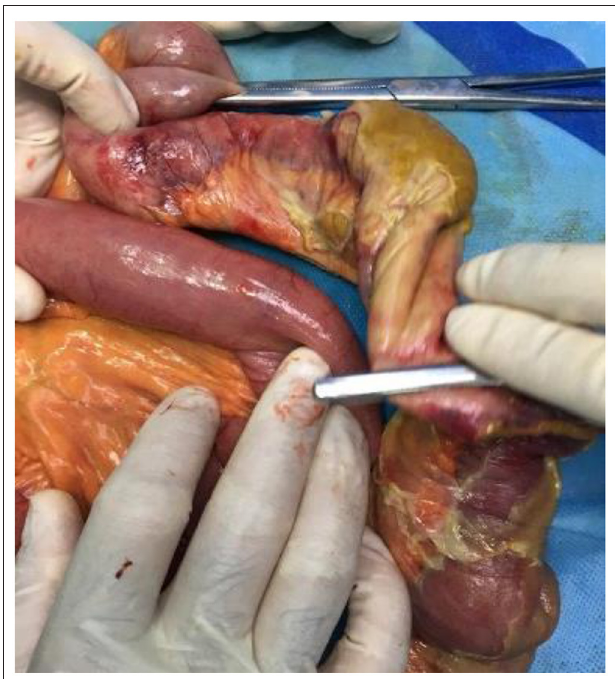
FIGURE 1 | Yellow appearance of the necrotic intestine found in the gross examination ( 17).